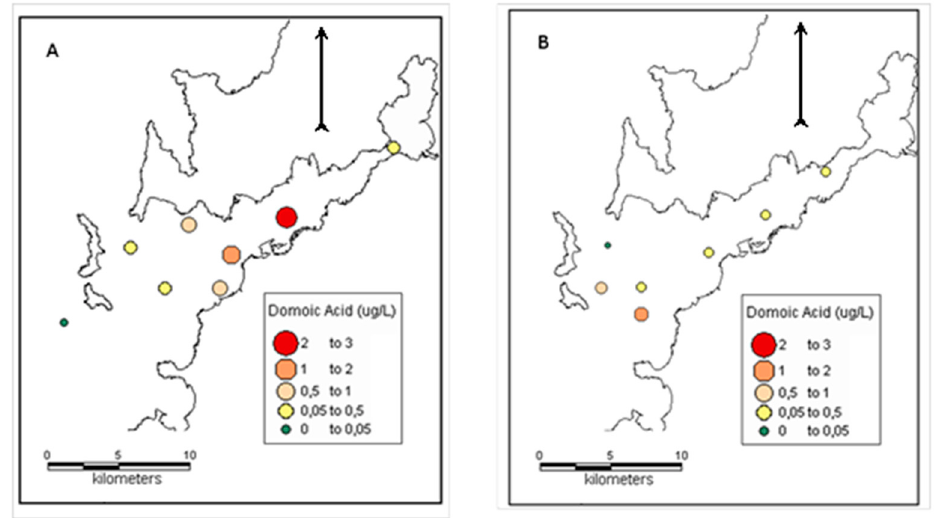
Figure 5. Distribution of particulate domoic acid (pDA) during the two high DA episodes recorded in the surface waters of Ria de Vigo on ( a ) 19 October 2007 and ( b ) 14 July 2009.